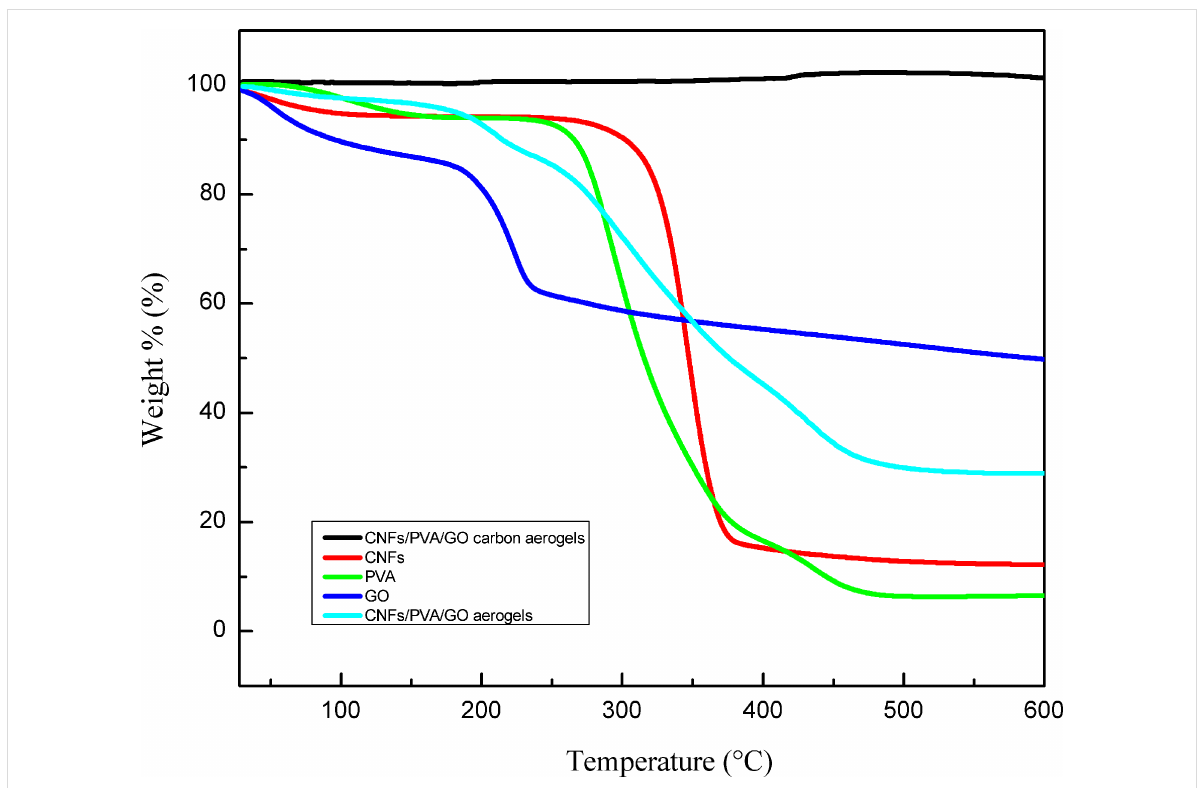
Figure 6: Thermogravimetric analysis (TGA) curves of the CNFs, pure PVA, GO, CNF/PVA/GO aerogel and the CNF/PVA/GO carbon aerogel.